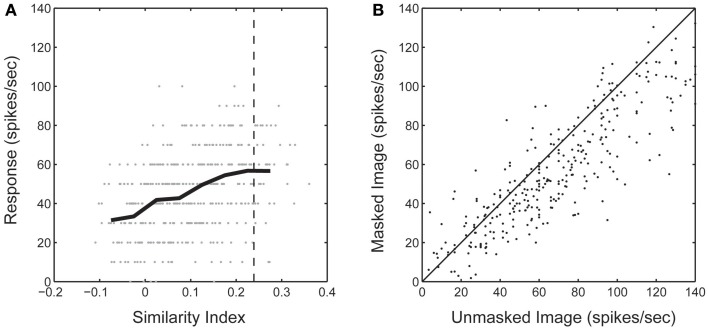
(A) Sorted neural response during the bubbles stimulus sequence from one neuron. Neural response is shown as a function of the similarity (dot product) between each frame of the bubbles mask stimuli and the resultant spike-triggered mask. Negative values can be achieved due to the suppressive components of the spike-triggered mask. Dashed line indicates 90th percentile threshold for this neuron. (B) Average response rate from the original unmasked natural image compared with the response from masked images with a similarity index in the 90th percentile.